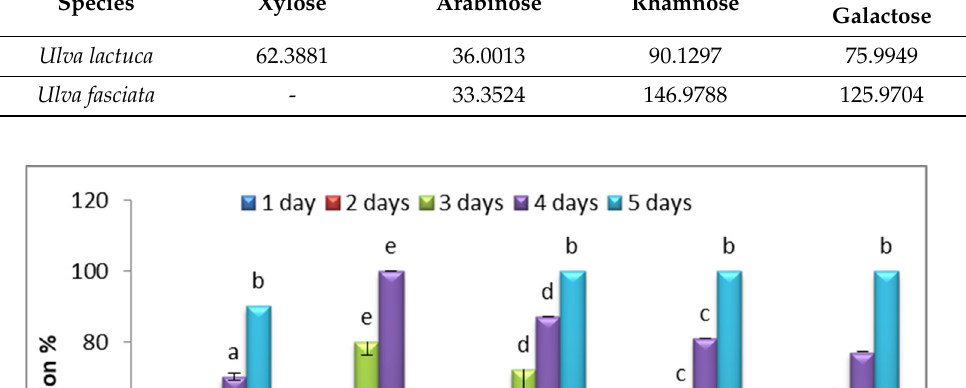
Figure 2. Effect of seed priming with different concentrations of soluble polysaccharides on the per- centage of seed germination recorded daily during the germination period of Zea mays . The bars represent the standard error (different letters denote the significant value among the treatments on the same day ( p value= 0.0000). U.f., Ulva fasciata; U.l. , Ulva lactuca.